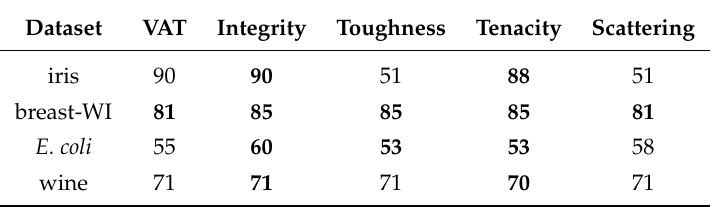
Table 6. Percent accuracy for NBR–Clustering on real point set data. Bold text indicates one-step clustering. Dataset VAT Integrity Toughness Tenacity